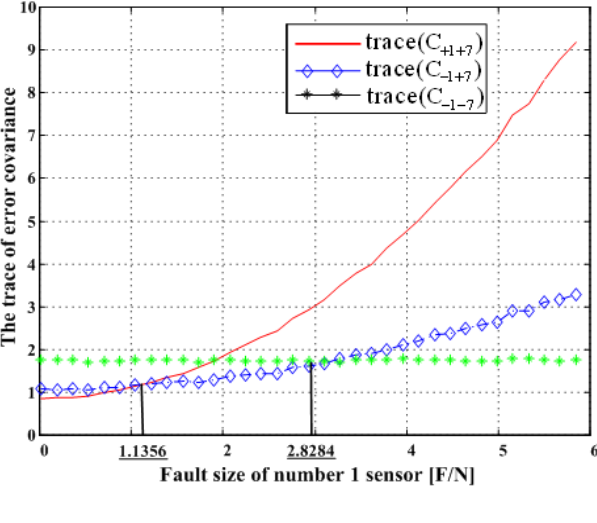
), trace(C )and trace(C ) with respect to fault magnitude in Figure +1+7 -1+7 -1-7